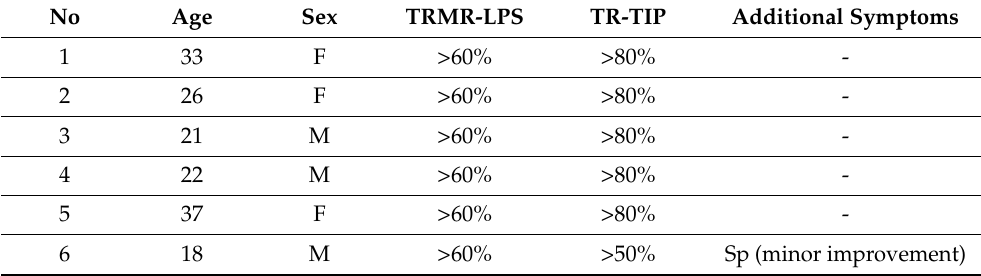
Table 2. Patients after surgery.